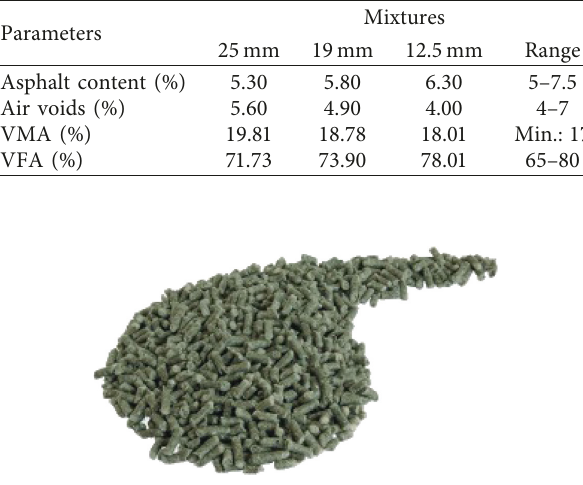
Figure 3: Cellulose fiber pellets used in SMA